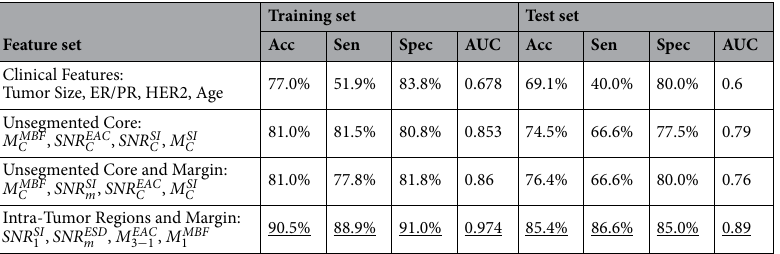
Table 2. Results of response prediction on the training and independent test sets using different clinical and QUS feature sets. Acc: Accuracy; Sen: Sensitivity; Spec: Specificity. The best value in each column is underlined